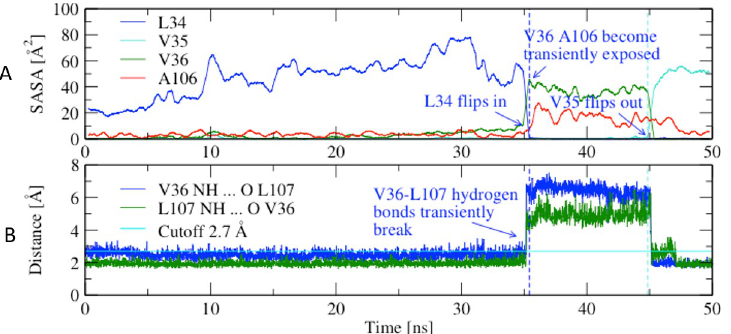
Fig 4. Conformational changes during a simulation of LAS to HAS transition. (A) SASA of L34 and V35 side chains. The values are averaged over a 0.5 -ns time window. Vertical dashed lines indicate the time point when L34 flips in (blue) and the time point when V35 flips out (red), respectively. Flipping in or out, respectively, was defined when the SASA of the respective side chain (in the 0.5-ns time averaged values) became less than or larger than 2 Å 2 , respectively. (B) Distances between atoms involved in the backbone hydrogen bonds between V36 and L107. Horizontal cyan line indicates the distance cutoff used to define a hydrogen bond, i.e., 2.7 Å